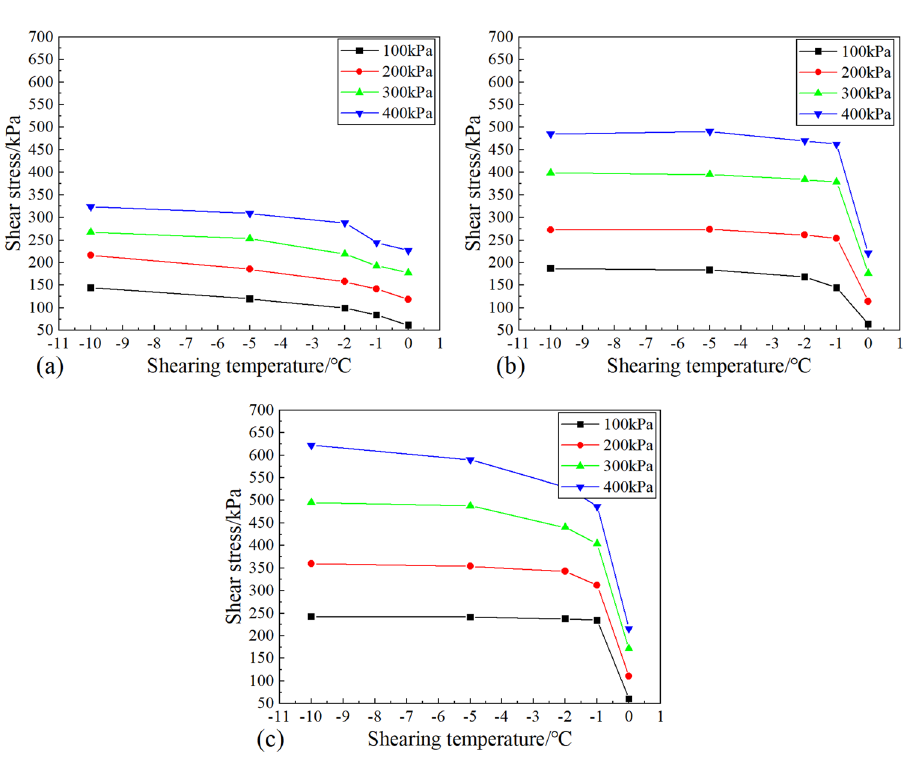
Figure 4. Effect of shear temperature on the shear strength of soil-ice interface: ( a ) moisture content 9.0%; ( b ) moisture content 16.0%; ( c ) moisture content